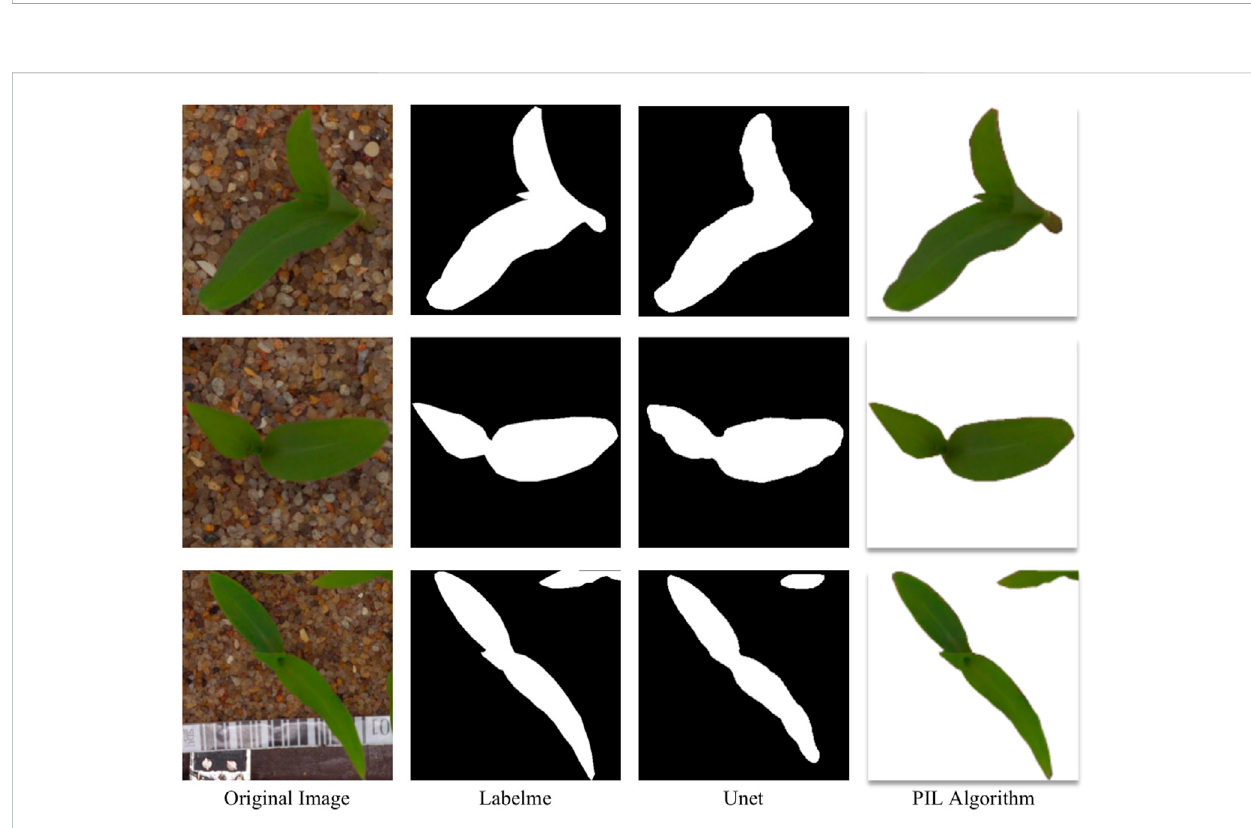
FIGURE 3 Sample segmentation diagram of partial data